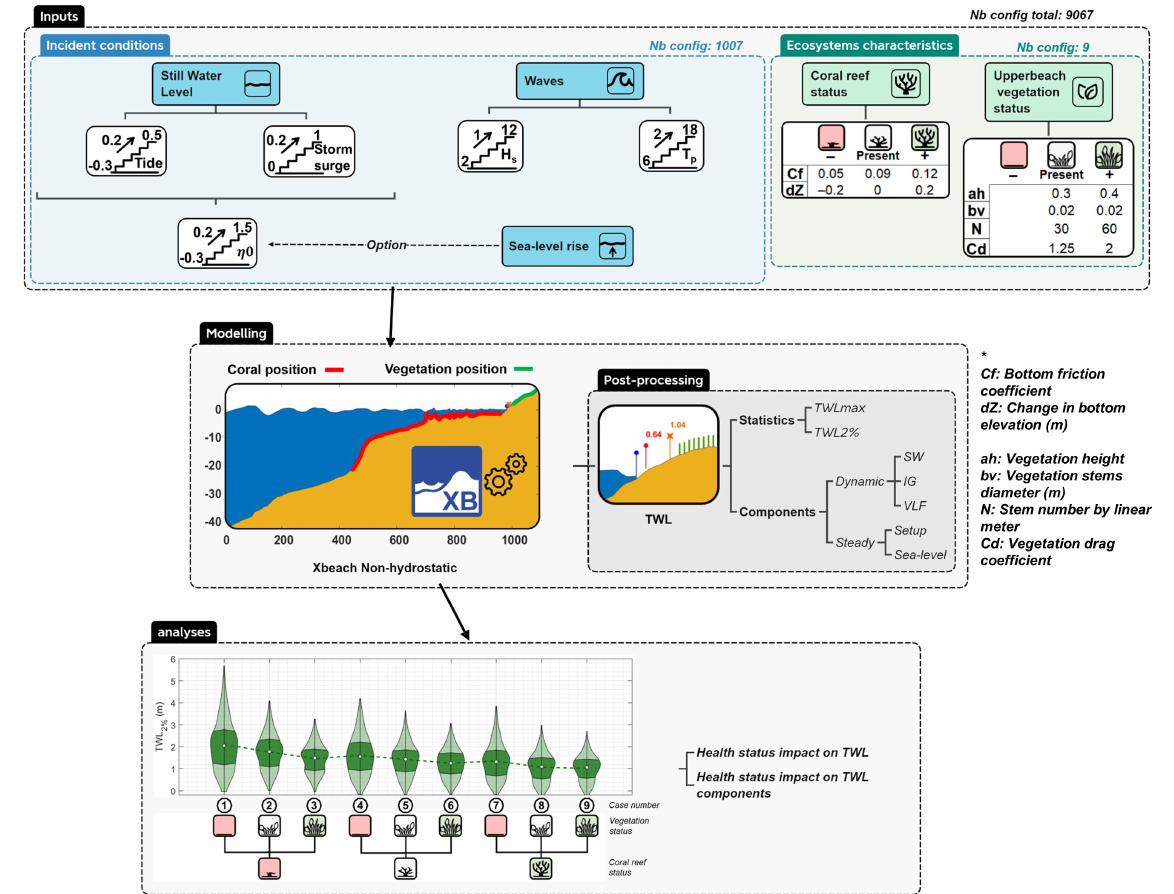
Figure 4. Global modeling strategy flowchart. The incident conditions are detailed in the blue box which include ranges for the still water level ( η 0), the significan wave height ( H s ) and pek period ( T p ). Ecosystems characteristics are detailed in the the green box. It includes the bottom friction coefficient ( Cf ) and the bottom layer change ( dZ ) for the coral reef and height ( ah ), stems diameter ( bv ), number of stems per linear meter ( N ) and drag coefficient ( Cd ) for the vegetation. The middle box schematizes modeling profile and output extractions. The lower box schematizes analyses performed on model